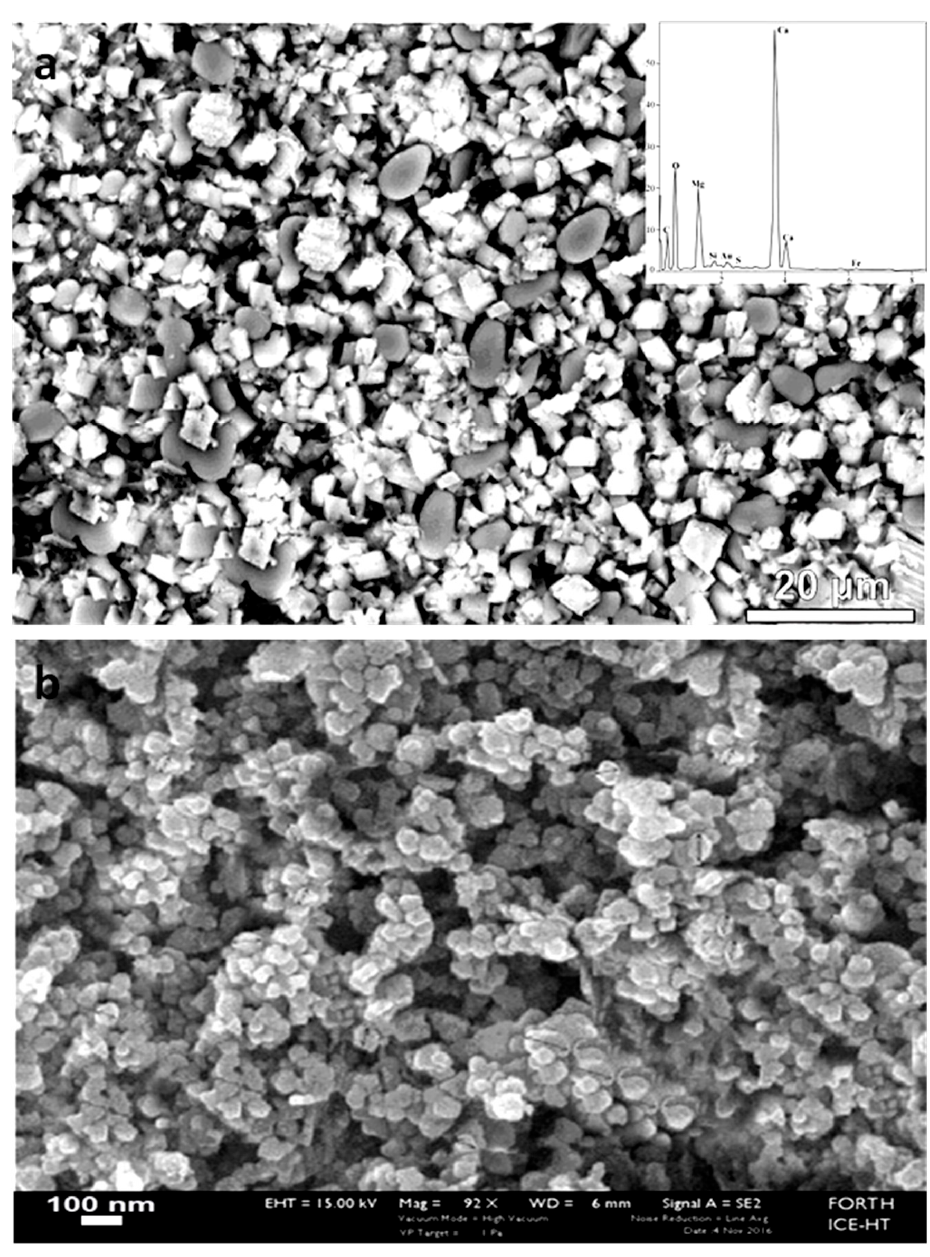
Figure 6. ( a,b ) Backscattered image indicating microregion in the matrix of the final product enriched in lime/portlandite (white), and periclase (grey).